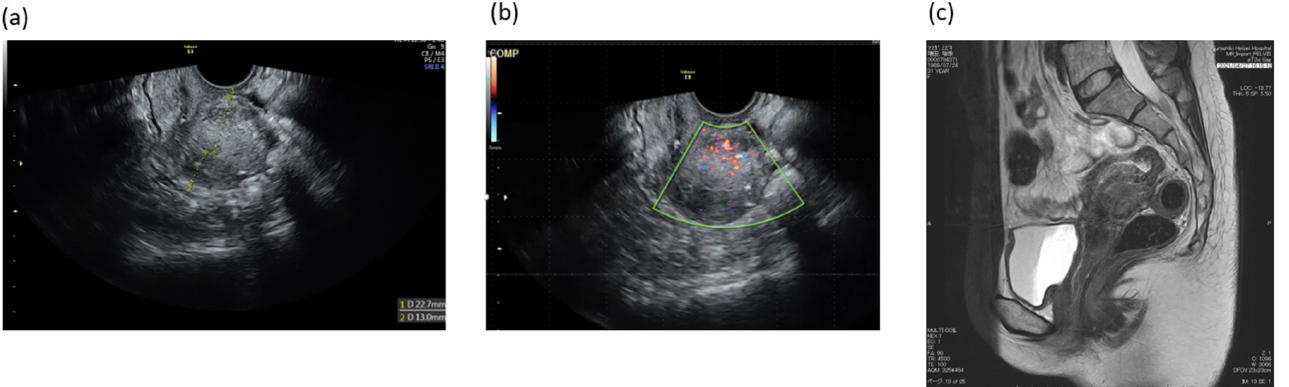
Figure 5. ( a ) Two months after surgery, a transvaginal ultrasound shows that the thickness of the posterior wall of the uterus had decreased from 28 to 22.7 mm. ( b ) Transvaginal Doppler ultrasound showing good recovery of blood flow in the repaired muscle layer. ( c ) Sagittal T2-weighted postoperative pelvic magnetic resonance imaging. The image shows